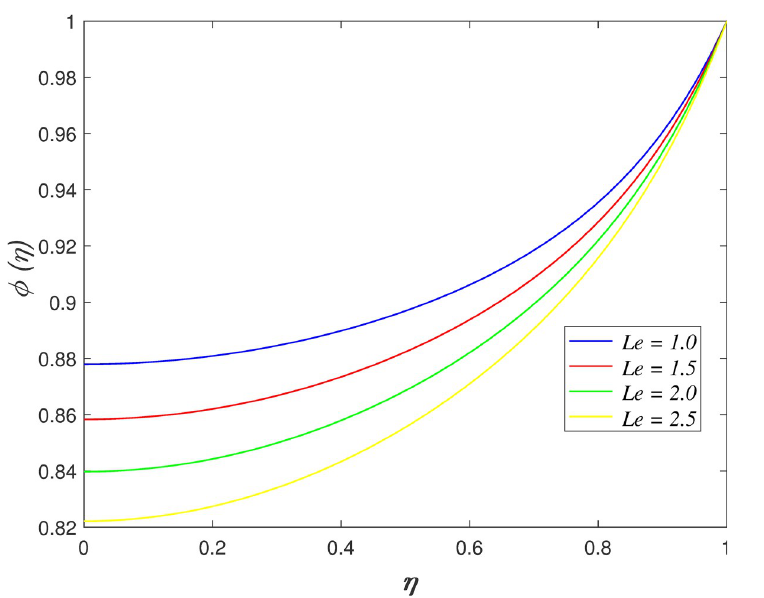
Fig 24. Impact of Le on concentration.